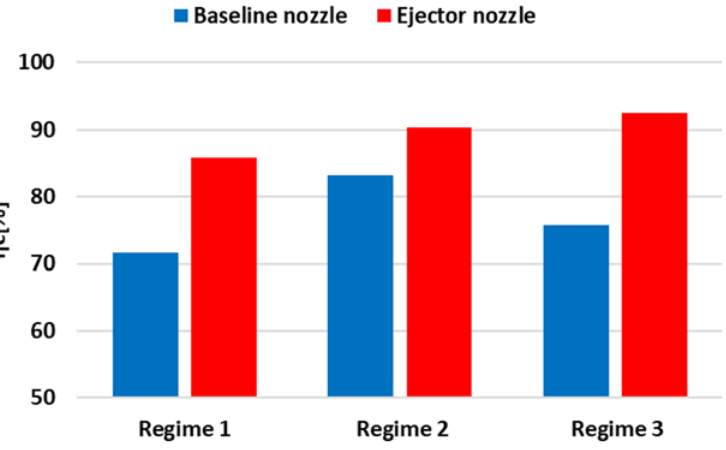
Figure 19. Variation of the compressor efficiency depending on the regime and nozzle type.